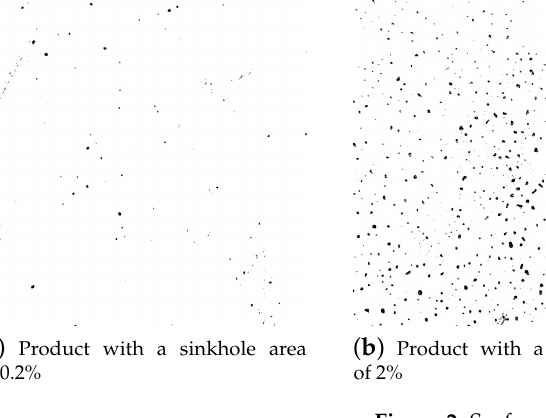
Figure 2. Surface void